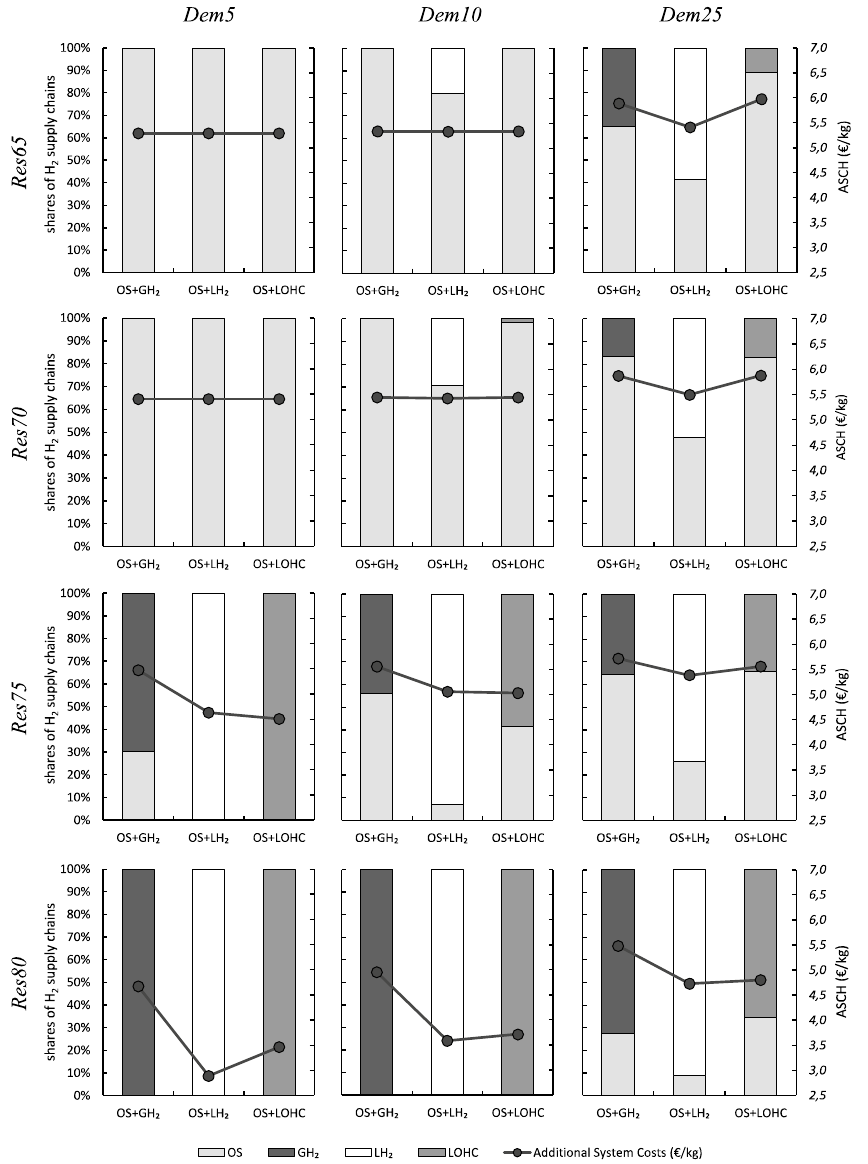
Figure 2. Optimal combinations of small-scale on-site (OS) and large-scale hydrogen supply chains and Additional System Costs of Hydrogen (ASCH) for the 12 scenarios. Starting from the top left panel, the share of renewable energy sources increases to the bottom, and the demand for hydrogen increases to the